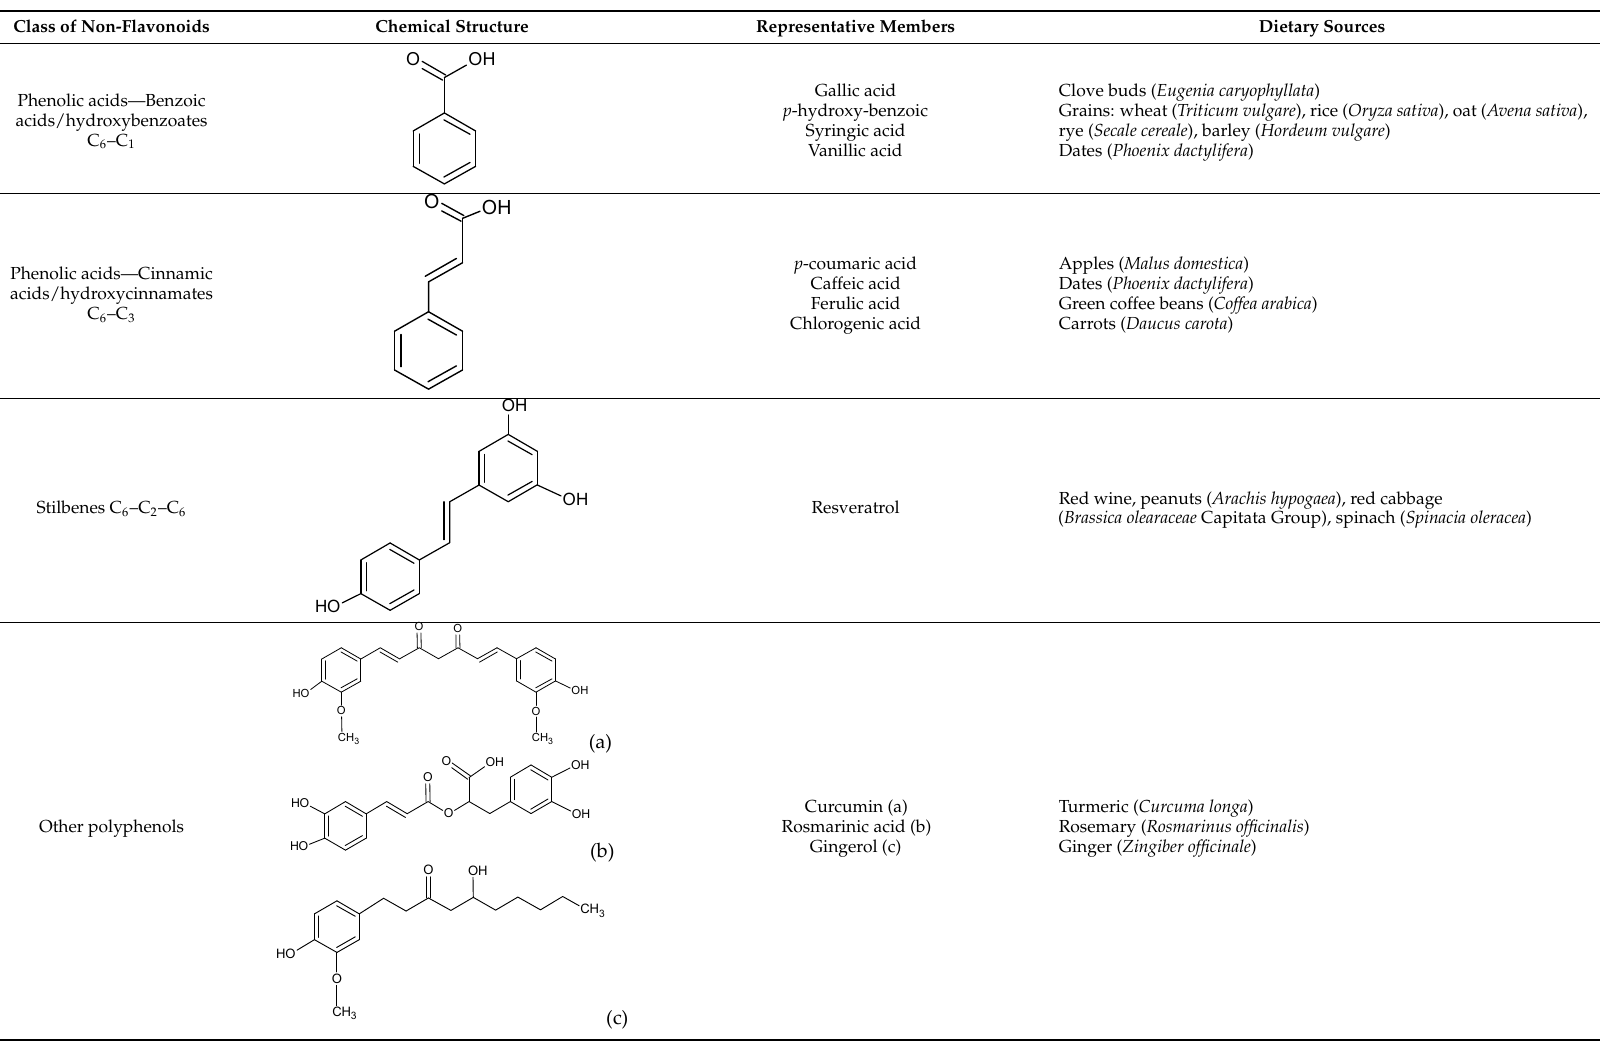
Table 2. The main classes of non-flavonoid polyphenols with chemical structure, representative members and dietary sources [36,39,45].